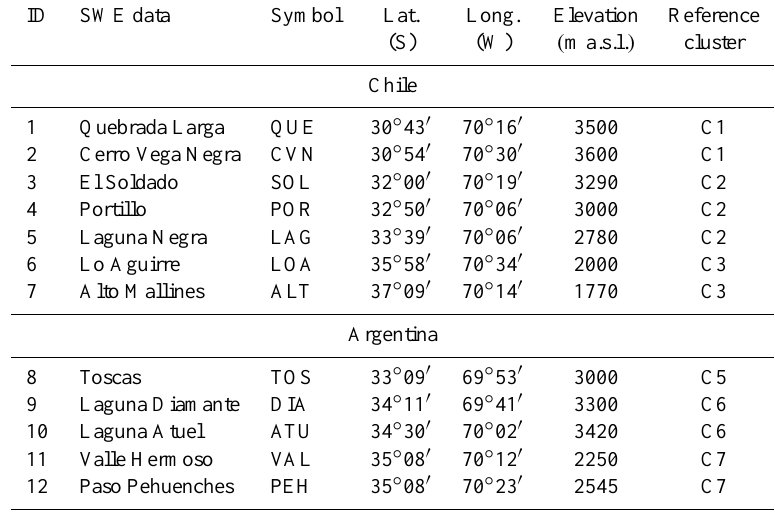
Table 2. Snow-pillow measurements available within the study domain.